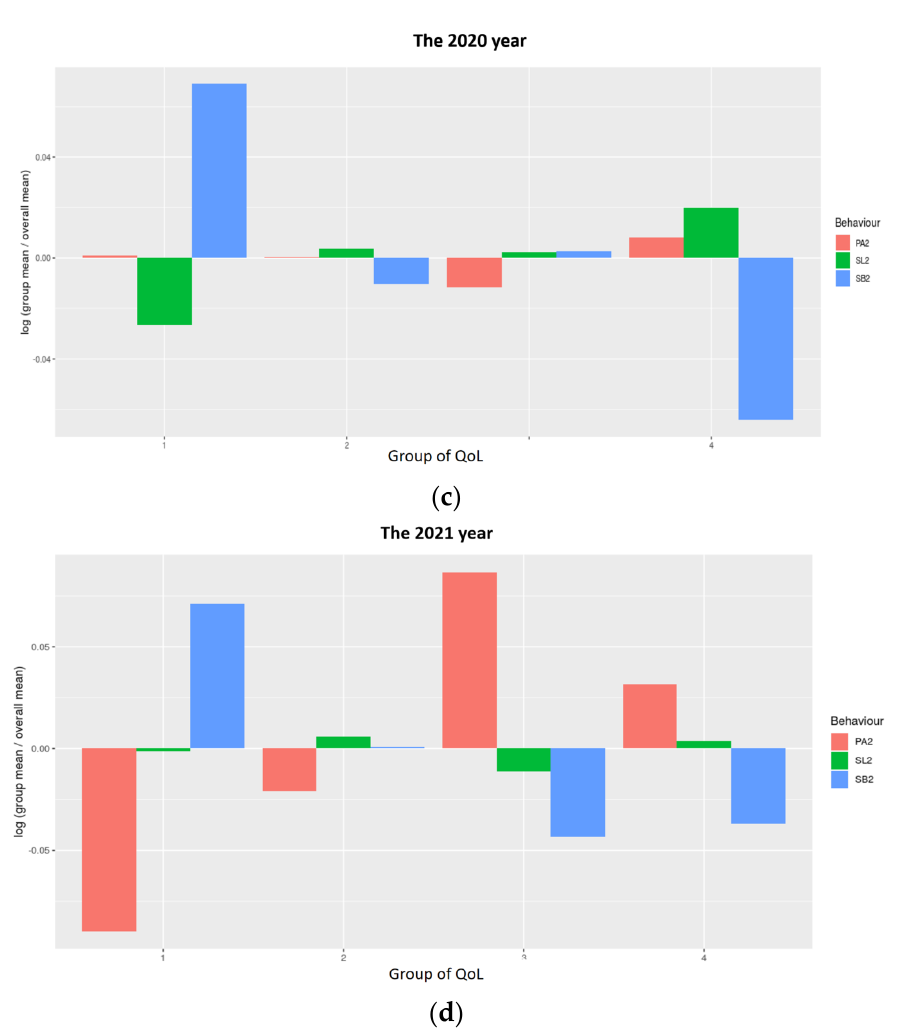
Figure 2. Composition of a 24-h day in PA, SB, and SL grouped by 1–4 Qol quantiles as compositional data analysis of the relative importance of the group mean time spent in PA, SB, and SL with respect to the overall compositional mean time from 2018 to 2021 ( a – d ). The y -axis displays the log-ratio value of compositional means by group (and overall) while the x -axis shows the quality of life (QoL) quantiles.